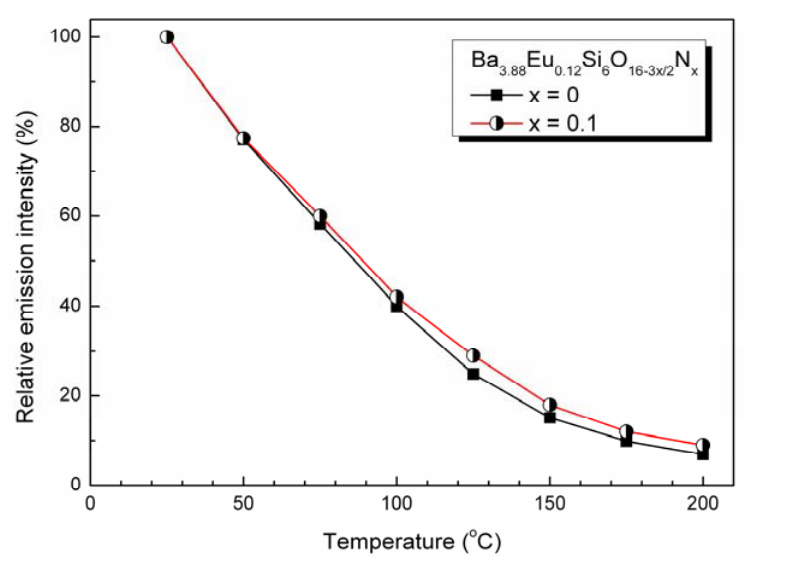
Figure 10. Temperature dependence of Ba = 340 ( λ exc